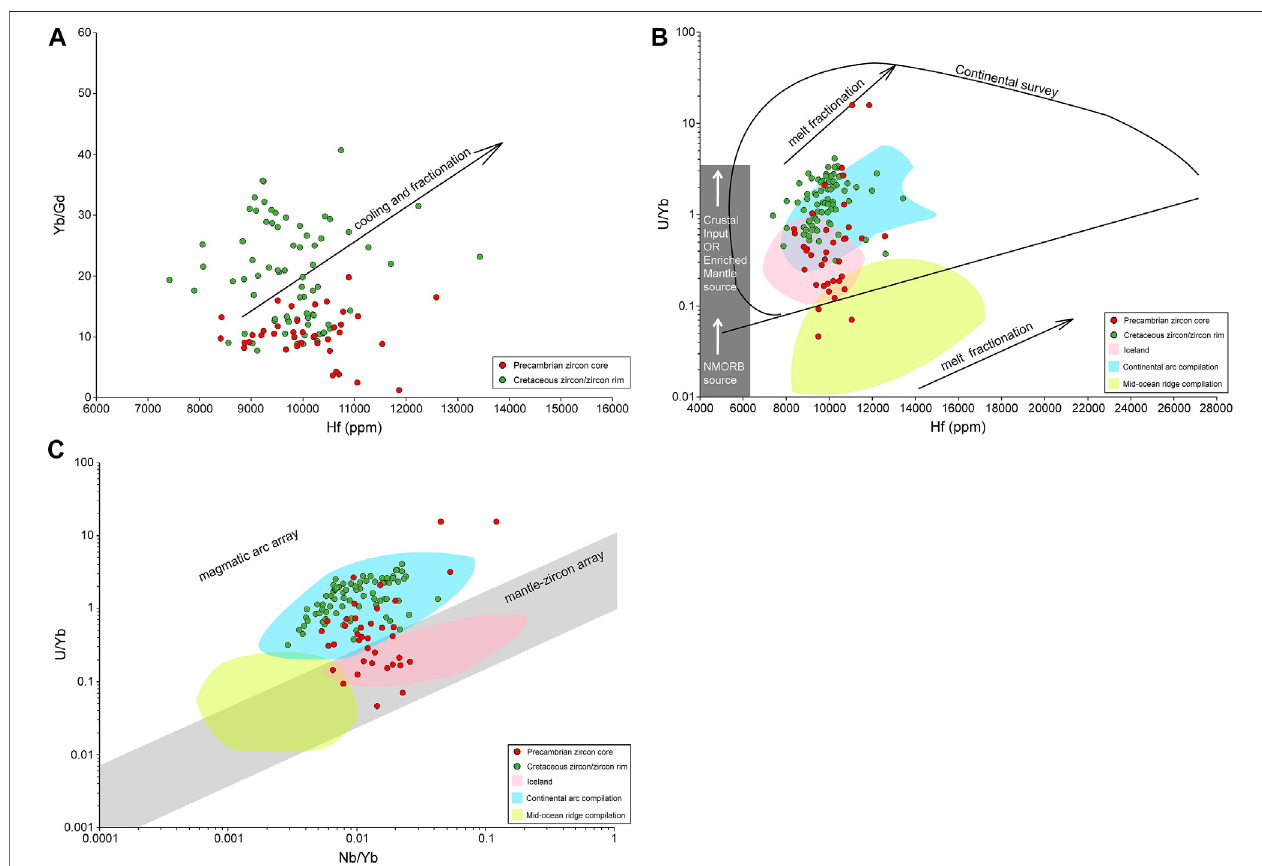
FIGURE 12 | Plots of (A) Yb/Gd vs. Hf (base map from Barth and Wooden, 2010), (B) U/Yb vs. Hf (base map from Grimes et al., 2015), and (C) U/Yb vs. Nb/Yb (base map from Grimes et al., 2015) for zircons from the Huaibei-Linhuan intrusive rock samples.